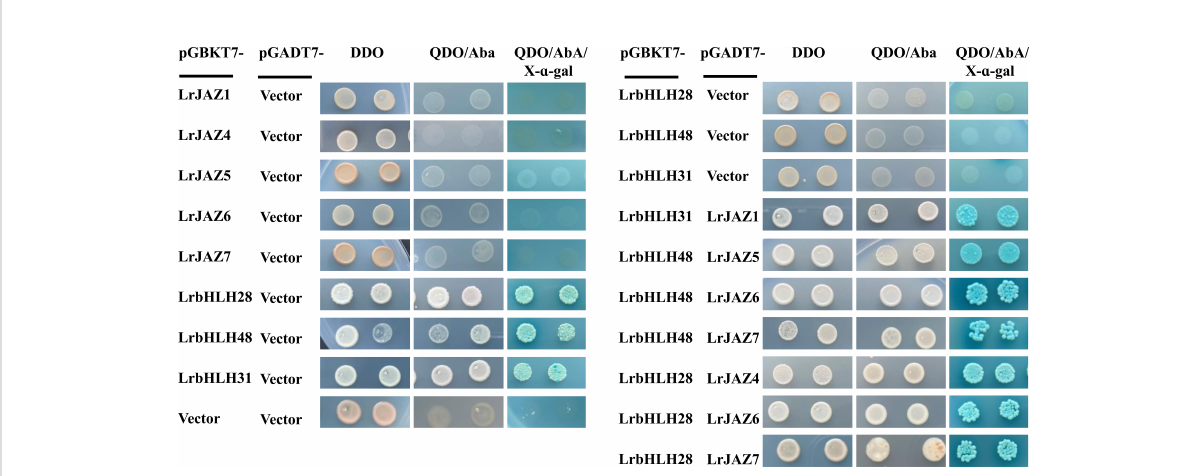
FIGURE 9 The protein-protein interactions between LrbHLHs and LrJAZs detected by yeast two-hybrid (Y2H) system. The coding sequences of LrbHLH28 , LrbHLH31 and LrbHLH48 were ligated to the GAL4 activation domain (AD) and DNA-binding domain (BD), whereas the sequences of JAZ genes were fused to the GAL4 activation domain (AD). Positive control, negative control, and the fusion constructs were transformed into the Y2H strain and successively incubated in DDO (SD/-Leu/-Trp) medium, QDO (SD/-Ade/-Leu/-Trp/-His) medium supplemented with Aureobasidin A (AbA) and QDO medium supplemented with 5-bromo-4-chloro-3-indoxyl a -D-galactoside (X- a -Gal) and